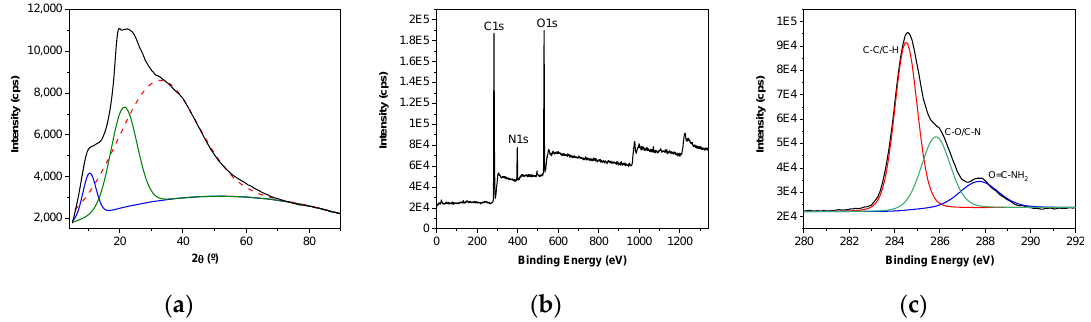
Figure 5. ( a ) X-ray diffraction (XRD) pattern, ( b ) X-ray photoelectron spectroscopy (XPS) survey data of SPI films, and ( c ) deconvolution of C1s spectrum.